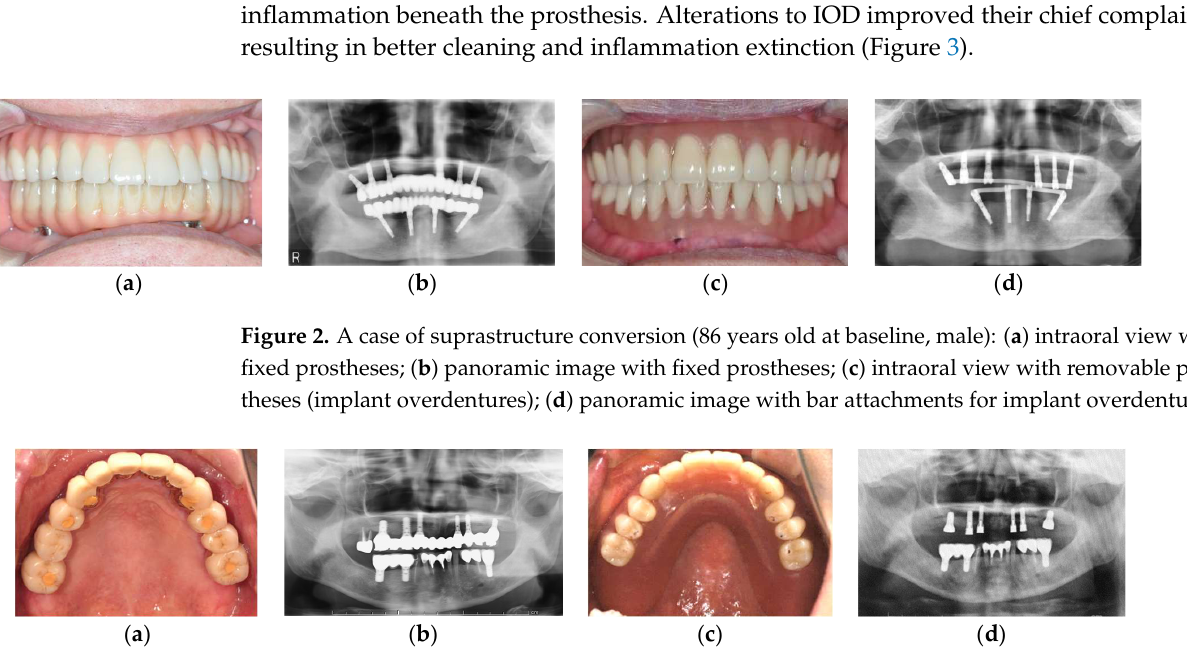
Figure 3. A case of suprastructure conversion (70 years old at baseline, female): ( a ) occlusal view with fixed prosthesis; ( b ) panoramic image with fixed prostheses; ( c ) occlusal view with removable prosthesis (implant overdenture); ( d ) panoramic image with magnet attachments for implant overdenture.